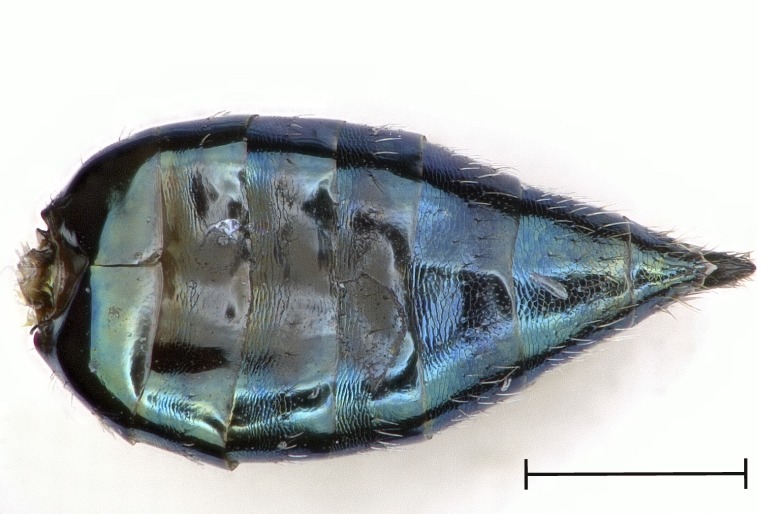
Gaster, dorsal view.